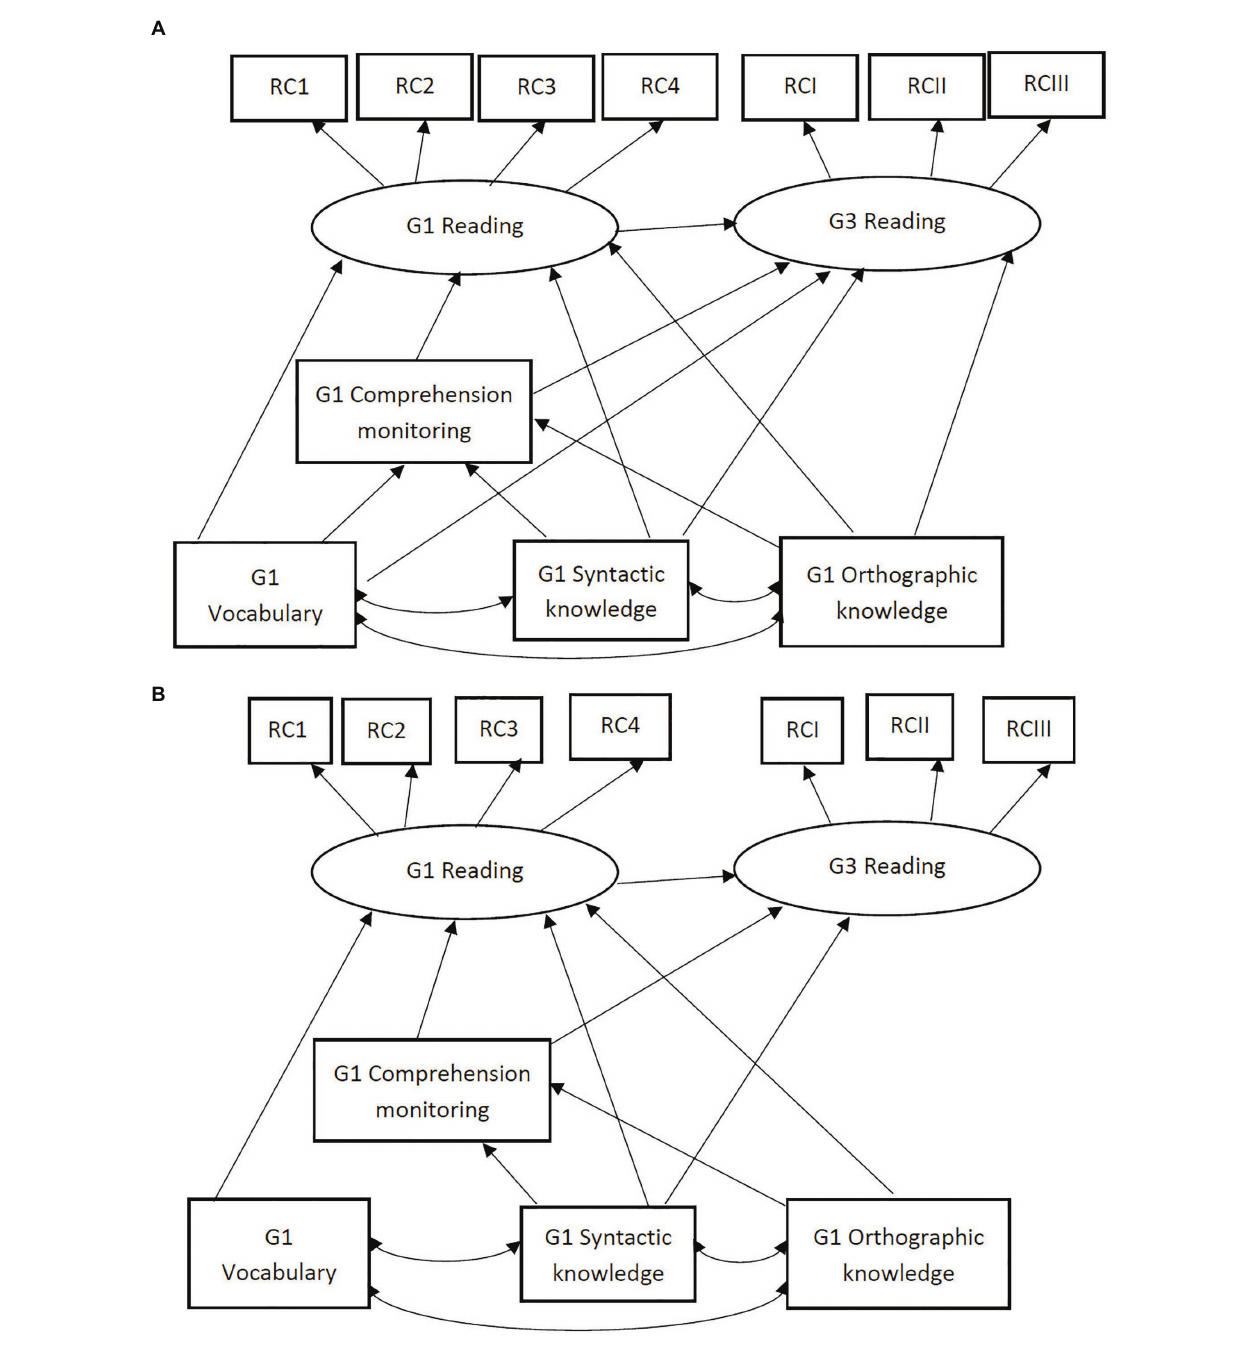
FIGURE 2 | Two alternative models of longitudinal relations among Grade 3 reading, Grade 1 reading, comprehension monitoring, and language skills. In (A) , vocabulary and orthographic knowledge in Grade 1 are directly and indirectly related to Grade 3 reading; In (B) , vocabulary and orthographic knowledge in Grade 1 are indirectly related to Grade 3 reading. G1 = Grade 1; G3 = Grade 3; RC 1/2/3/4 = Reading comprehension task 1/2/3/4 in Grade 1; RCI/II/III = Reading comprehension task 1/2/3 in Grade